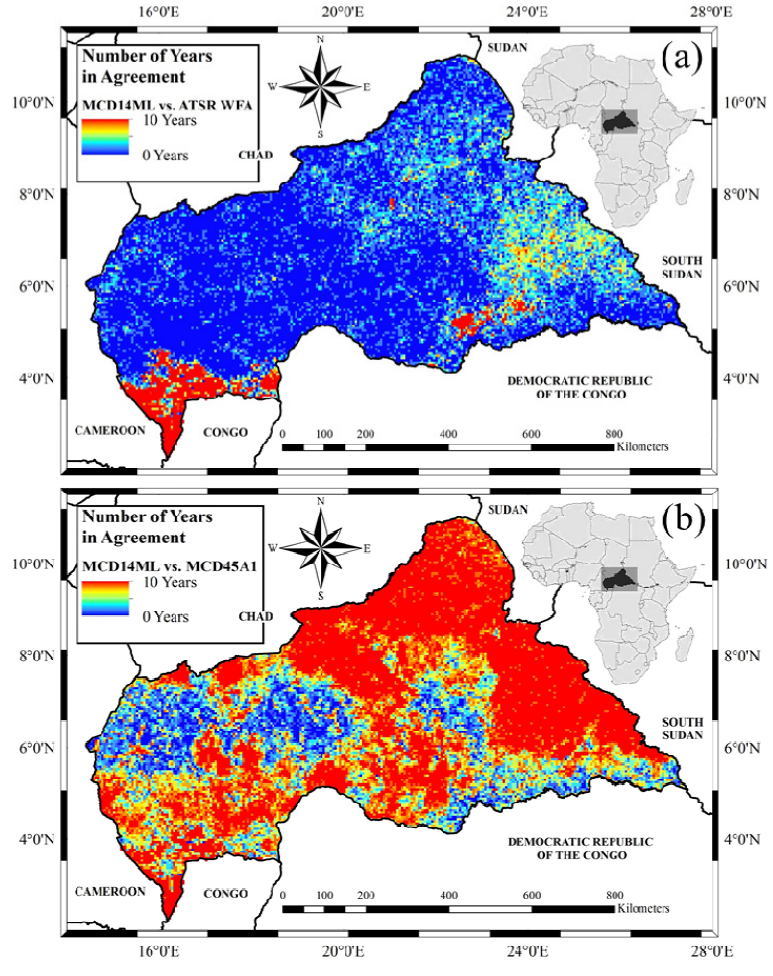
Figure 8. Maps of the agreement (in years; at 0.05° grid cell resolution) between fire chronologies derived from ( a ) the MODIS active fire product (MCD14ML) and the (A)ATSR nighttime world fire atlas (WFA); and ( b ) the MCD14ML active fire product and the MODIS burned area product (MCD45A1). A value of “10” (red) indicates that both satellite products generated an identical 10 year sequence of annual fire occurrence. A value of “0” (dark blue) indicates that annual fire occurrence derived from the dissimilar products disagreed in every